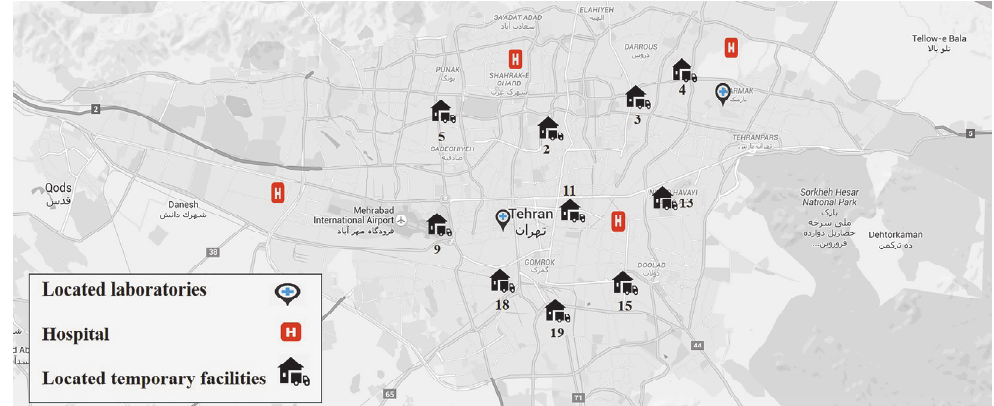
Fig. 4. Selected permanent blood facilities and